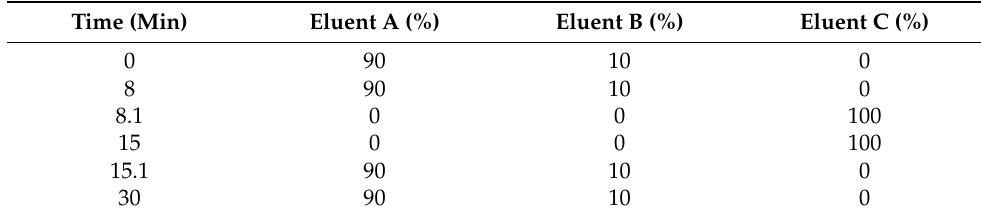
Table 1. Eluent conditions of HPAEC-PAD